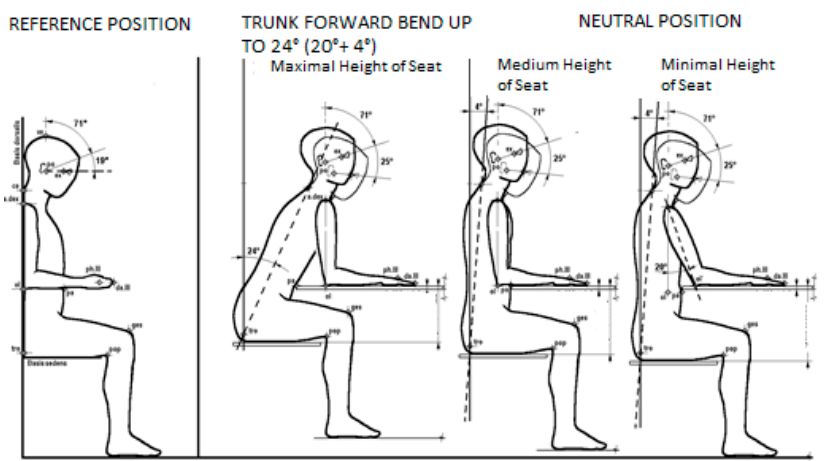
Figure 1. Individual adjustment of the set height of the chair and the lower limbs support to the height of the desk working surface [9].